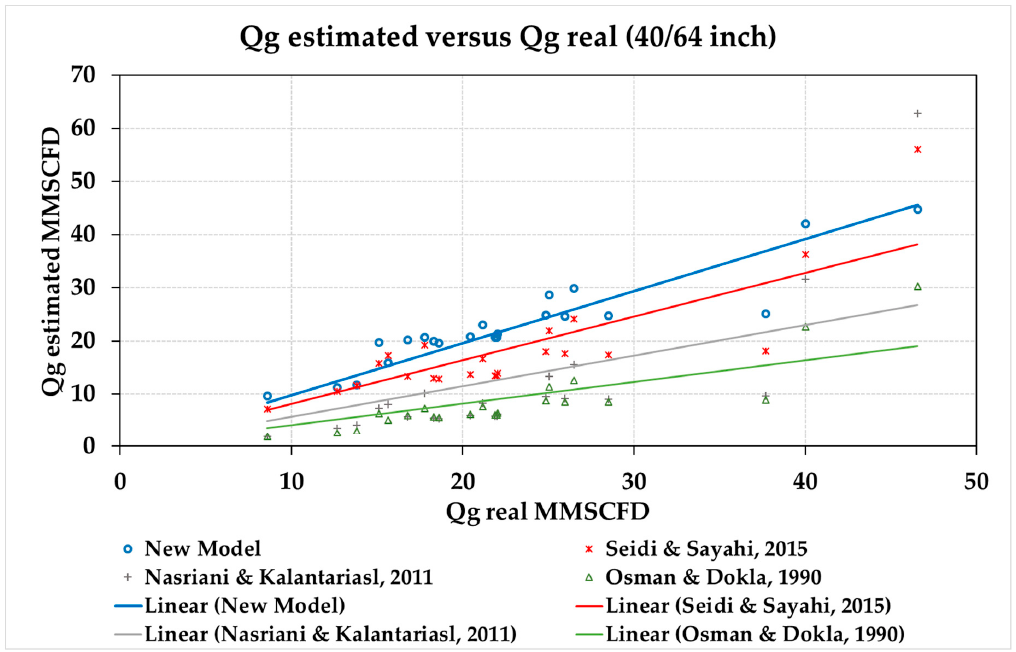
Figure 6 . Estimated gas flow rate versus real gas flow rate (40/64 inch) .